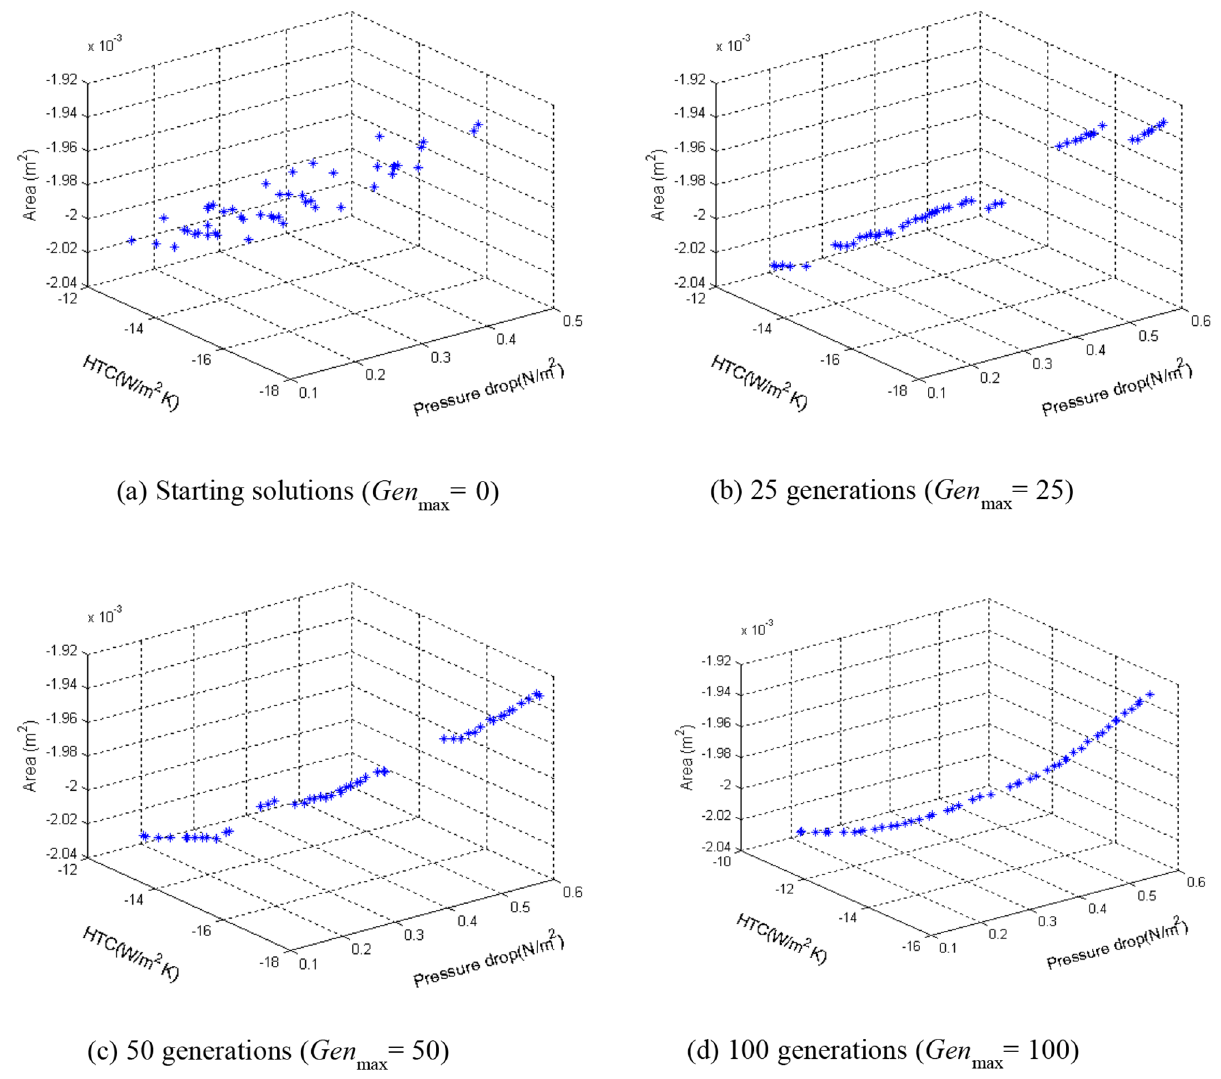
Fig. 10. Pareto optimal front of 3objectives and 6 design